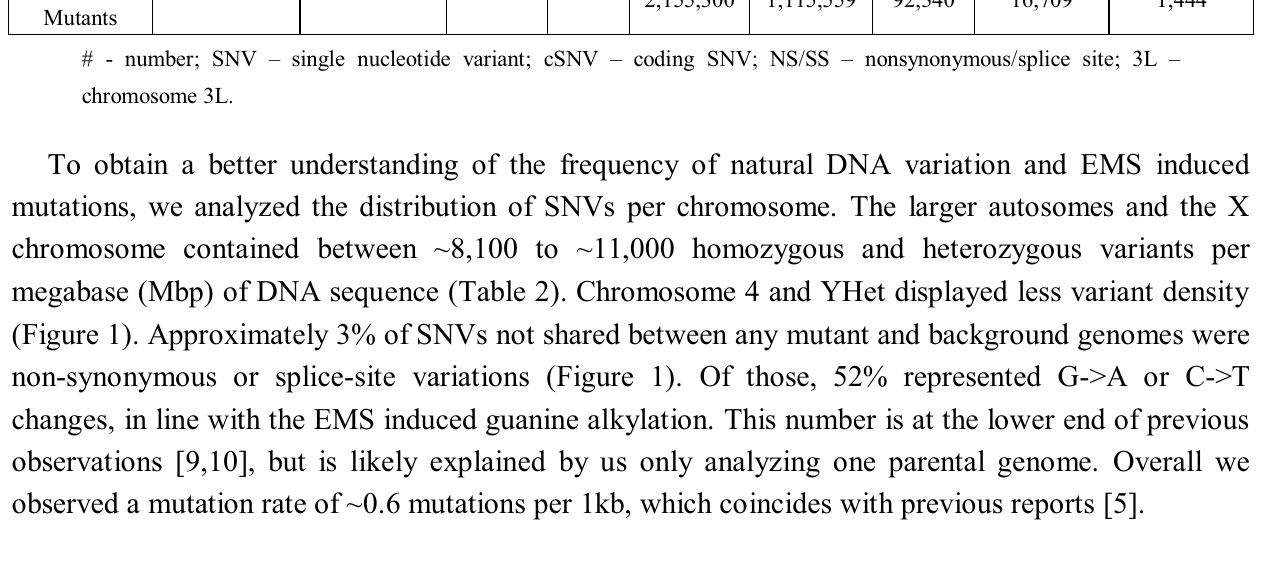
Table 2. Observed number of SNVs per million base pair (Mbp) in each